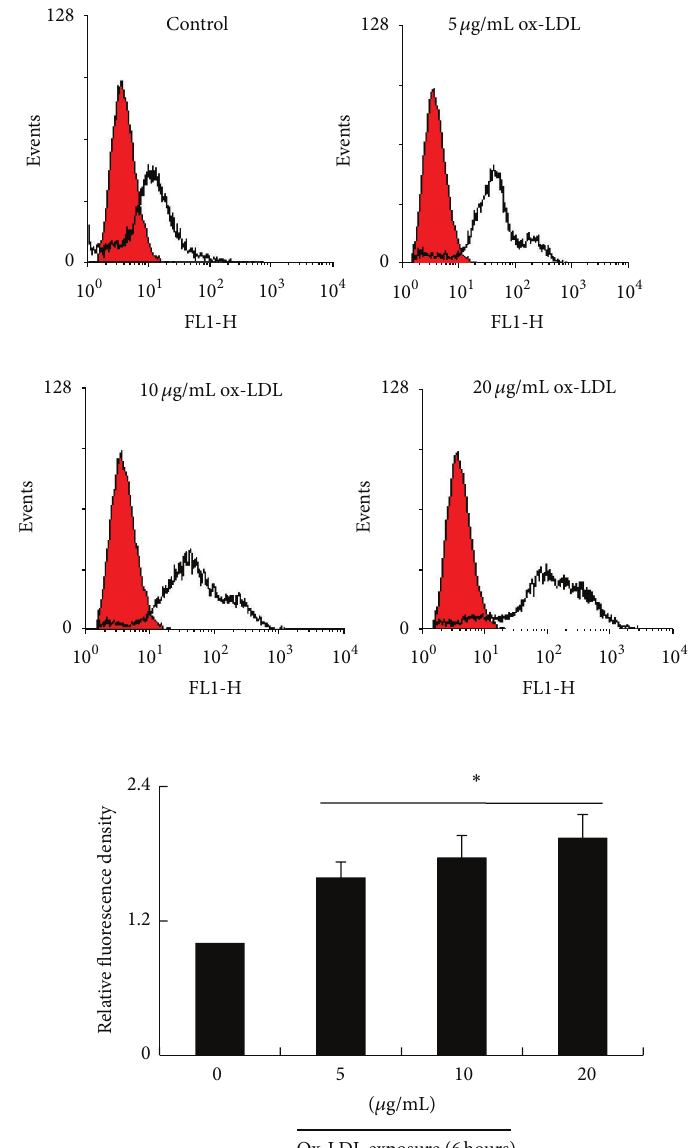
Figure 4: Flowcytometry assay shows the levels of intracellular Ca 2+ of bmMSCs exposed to 0, 5, 10, and 20 𝜇 g/mL ox-LDL for 6 hours. Bar graphs represent mean ± SD ( 𝑛 = 4 per group). ∗ 𝑃 < 0.01 versus